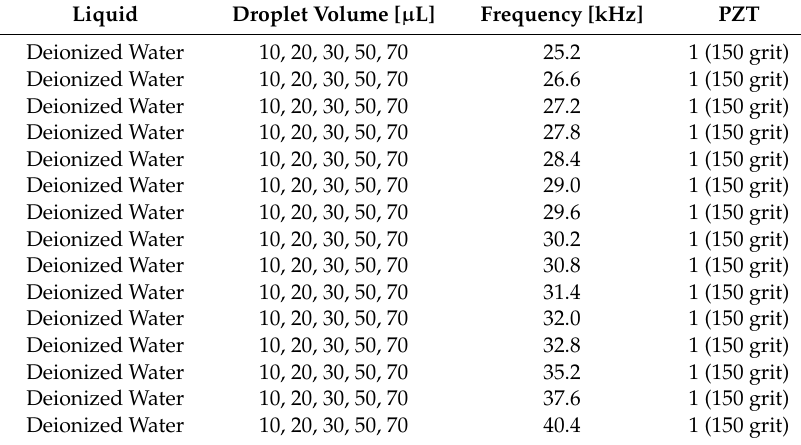
Table A8. Testing parameters used for the experiments conducted with deionized water to investigate the e ff ects of surface roughness using 150 grit sandpaper.